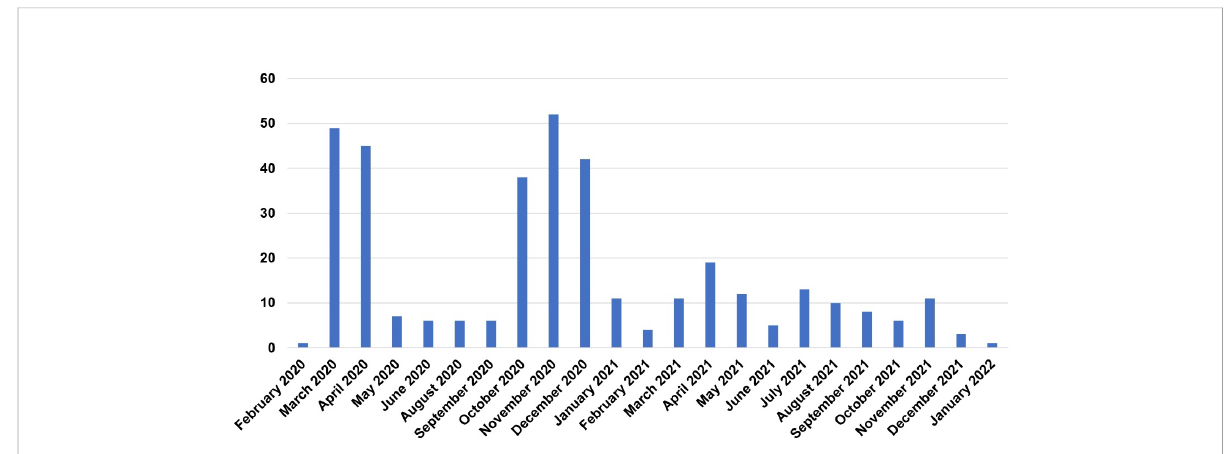
FIGURE 2 Distribution of registered cases along